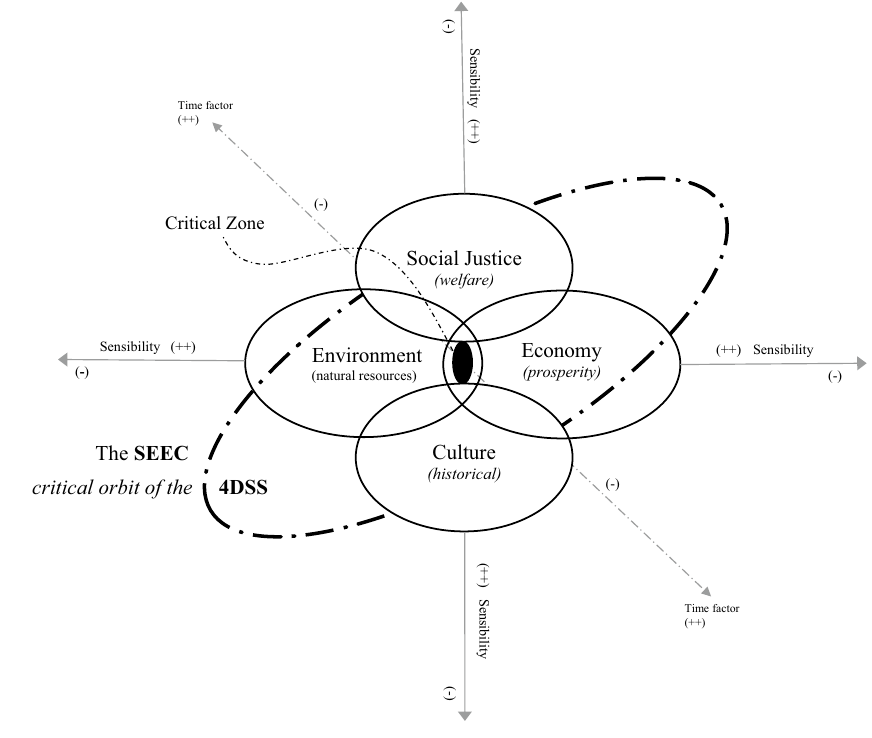
Fig. 4 Model 1: Spatial pres- entation of the 4DSS model and the generated SEEC orbit (social, economic, environ- mental, cultural-historical)– centered by multiple